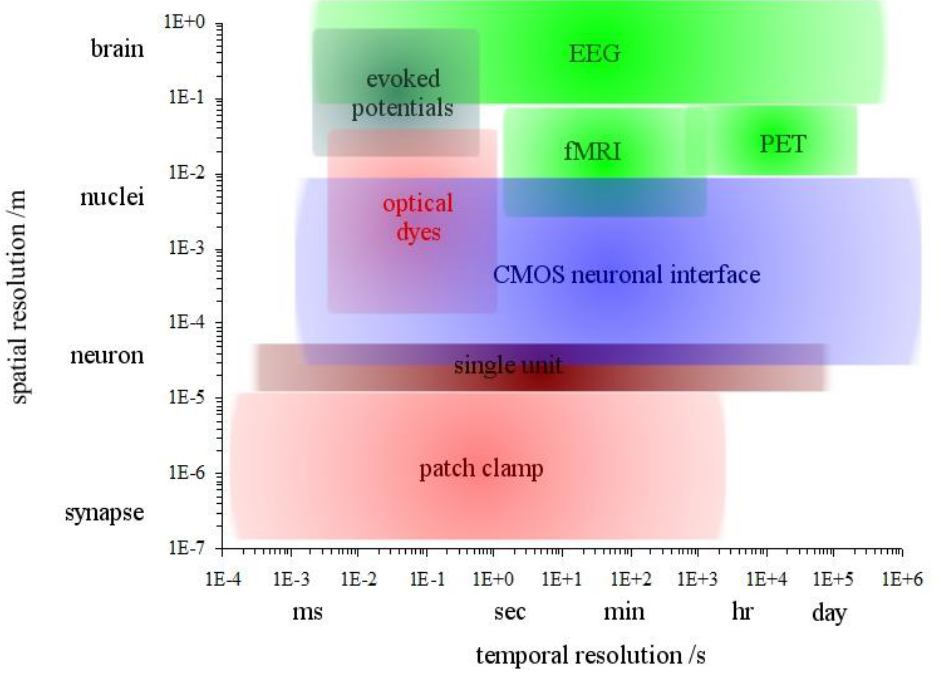
Figure 9. Map of imaging techniques on a spatial-temporal plane (adapted from